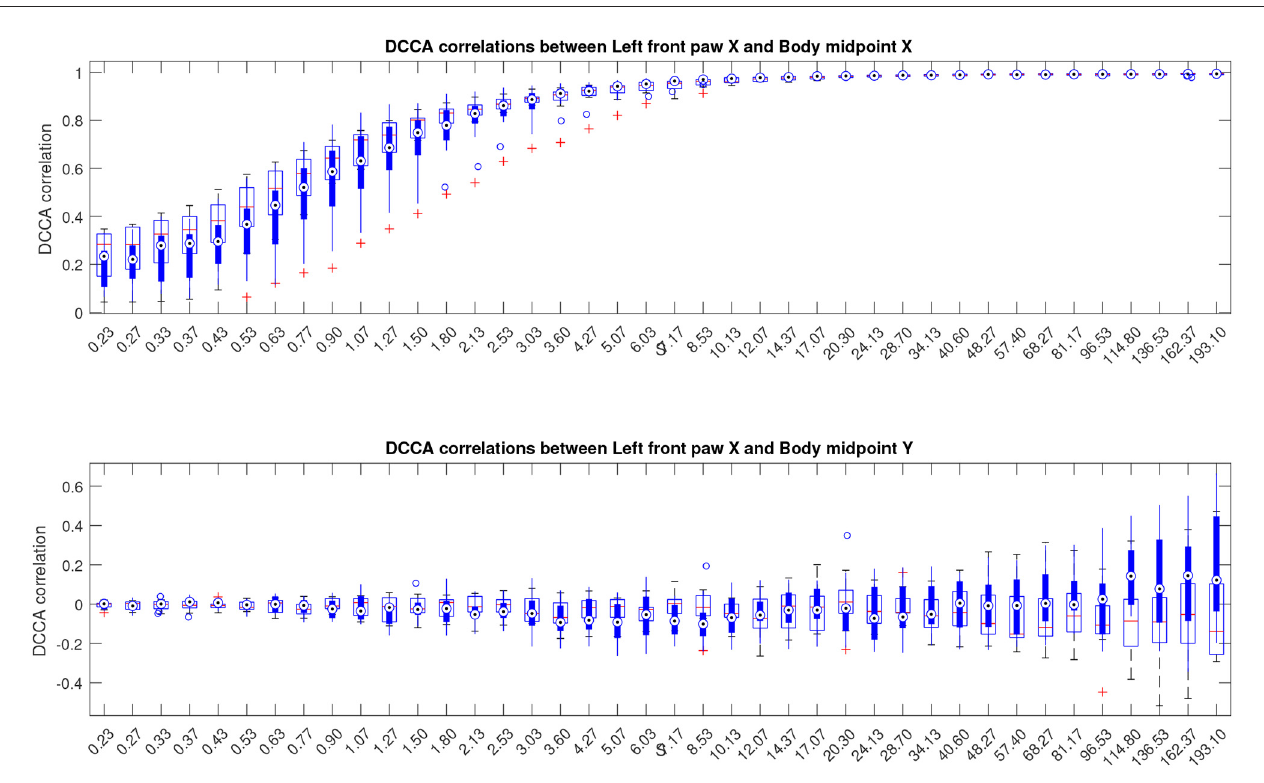
FIGURE4 Boxplots indicating correlation dynamics of the left front paw (acting as a representative example) along the X-axis relative to the animal body midpoint as a function of scale S obtained by detrended cross-correlation analysis (DCCA). The upper panel shows correlations with midbody movements along the same X-axis, representing specific correlations, while the lower panel shows correlations with midbody movements along the orthogonal Y-axis that one could expect to be unrelated, at least to a certain approximation, and thus indicating the level of unspecific correlations. More similar figures for other body parts are presented in the Supplementary material. Results for animals with Alzheimer’s disease are provided by filled boxes and blue circles for outliers; results for wild type animals (control group) are provided with open boxes and red plus signs for outliers.